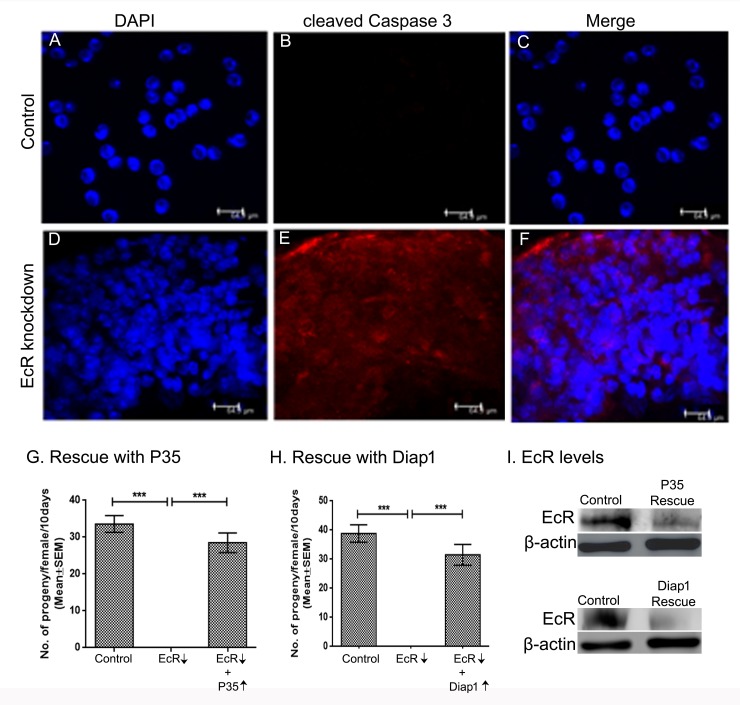
Analysis of cleaved Caspase 3 immunoreactivity in accessory glands of EcR control and knockdown males.To examine if loss of EcR leads to induction of apoptosis in accessory glands, tissues were immunostained with antibodies for cleaved Caspase 3, which react with initiator and effector caspases in Drosophila. Control tissues show well organized nuclei (Blue in color; DAPI, Panel A) and lack of detectable cleaved Caspase 3 immunoreactivity (Panel B) the overlay (Panel C) shows only the nuclei, in contrast, glands from EcR knockdown contain distorted as well as disorganized nuclei (DAPI, Panel D) and high levels of cleaved Caspase 3 immunoreactivity (Panel E). The overlay (Panel F) shows distorted nuclei (blue) and cleaved Caspase 3 labeling (red). (G) Females mated to EcR knockdown males over expressing P35 (EcR↓+P35↑) produced progeny at control levels as opposed to sterility in EcR knockdown mates (EcR↓, ***p<0.0001) indicating that over-expression of P35 rescued the fertility of EcR knockdown males. (H) EcR knockdown males overexpressing Diap1 (EcR↓+Diap1↑) were fertile as opposed to sterility in EcR knockdown mates (EcR↓, ***p<0.0001) indicating that overexpression of Diap1 rescued the fertility of EcR knockdown males. (I) Westerns blots of accessory gland proteins to confirm the knockdown status of EcR in males over expressing P35 (EcR↓+P35↑) or Diap1 (EcR↓+ Diap1↑) in EcR knockdown background. Blots were probed with anti-β-actin antibody as control for protein loading.